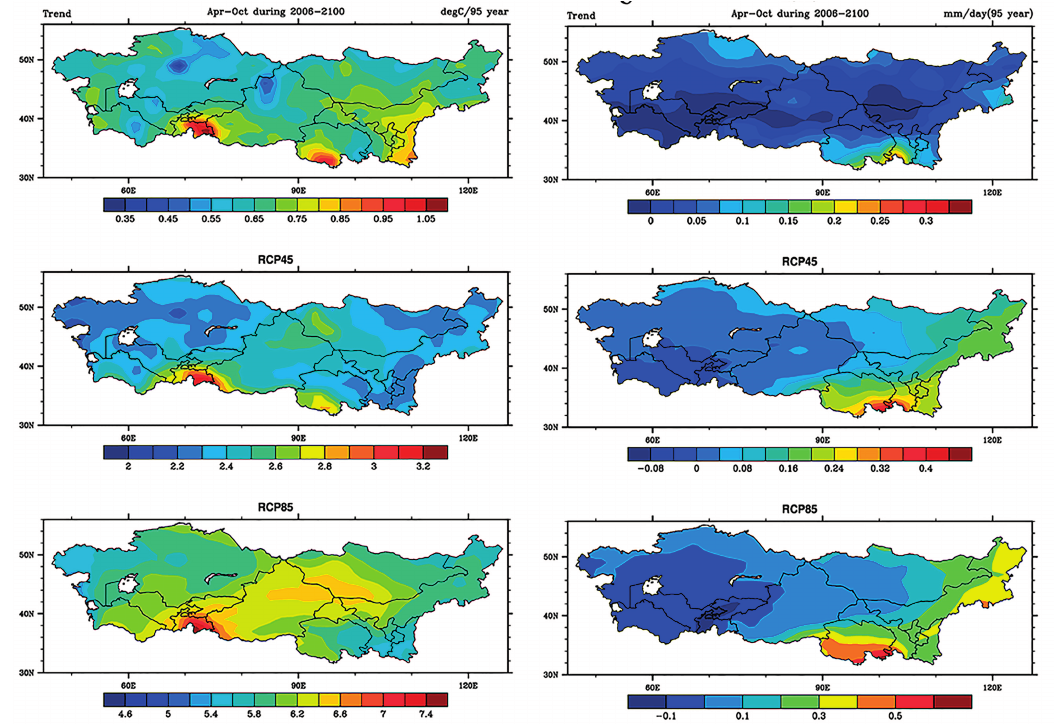
Figure 4. Future temperature ( a ) and precipitation ( b ) trends during the growing season from 2006–2100 in the three scenarios studied. Precipitation trends with black points are statistically significant at the 95% level. All temperature trends passed significance tests at the 95%